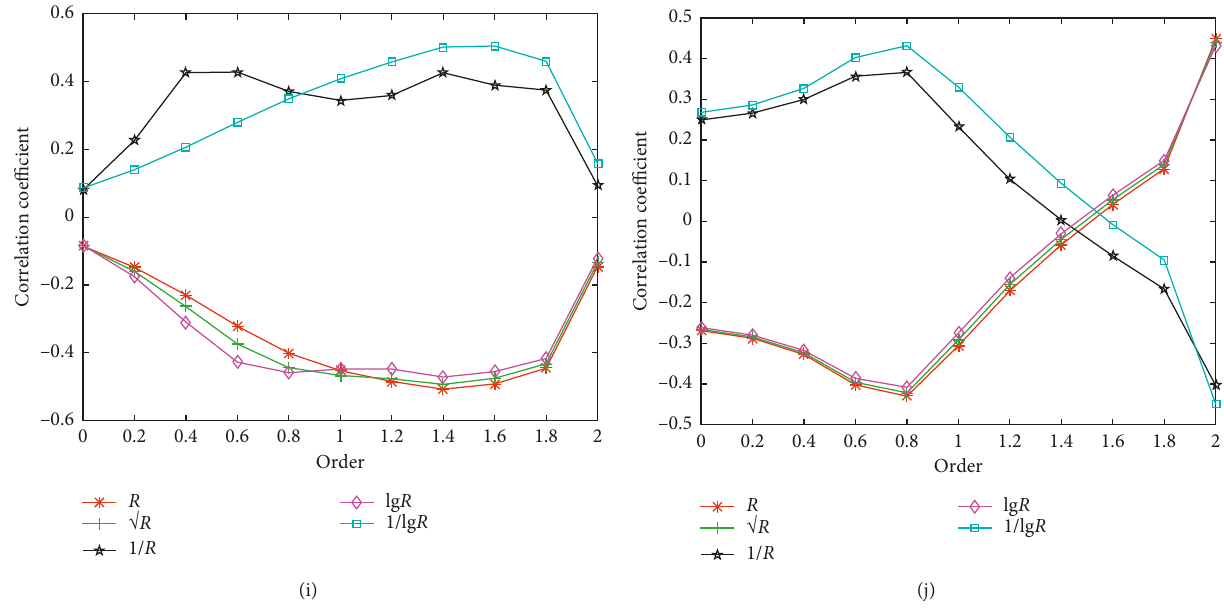
Figure 4: Correlation coefficient trending at bands of (a) 2310nm, (b) 2395nm, (c) 2327nm, (d) 667nm, (e) 648nm, (f) 623nm, (g) 681nm, (h) 570 nm, (i) 579nm, and (j)